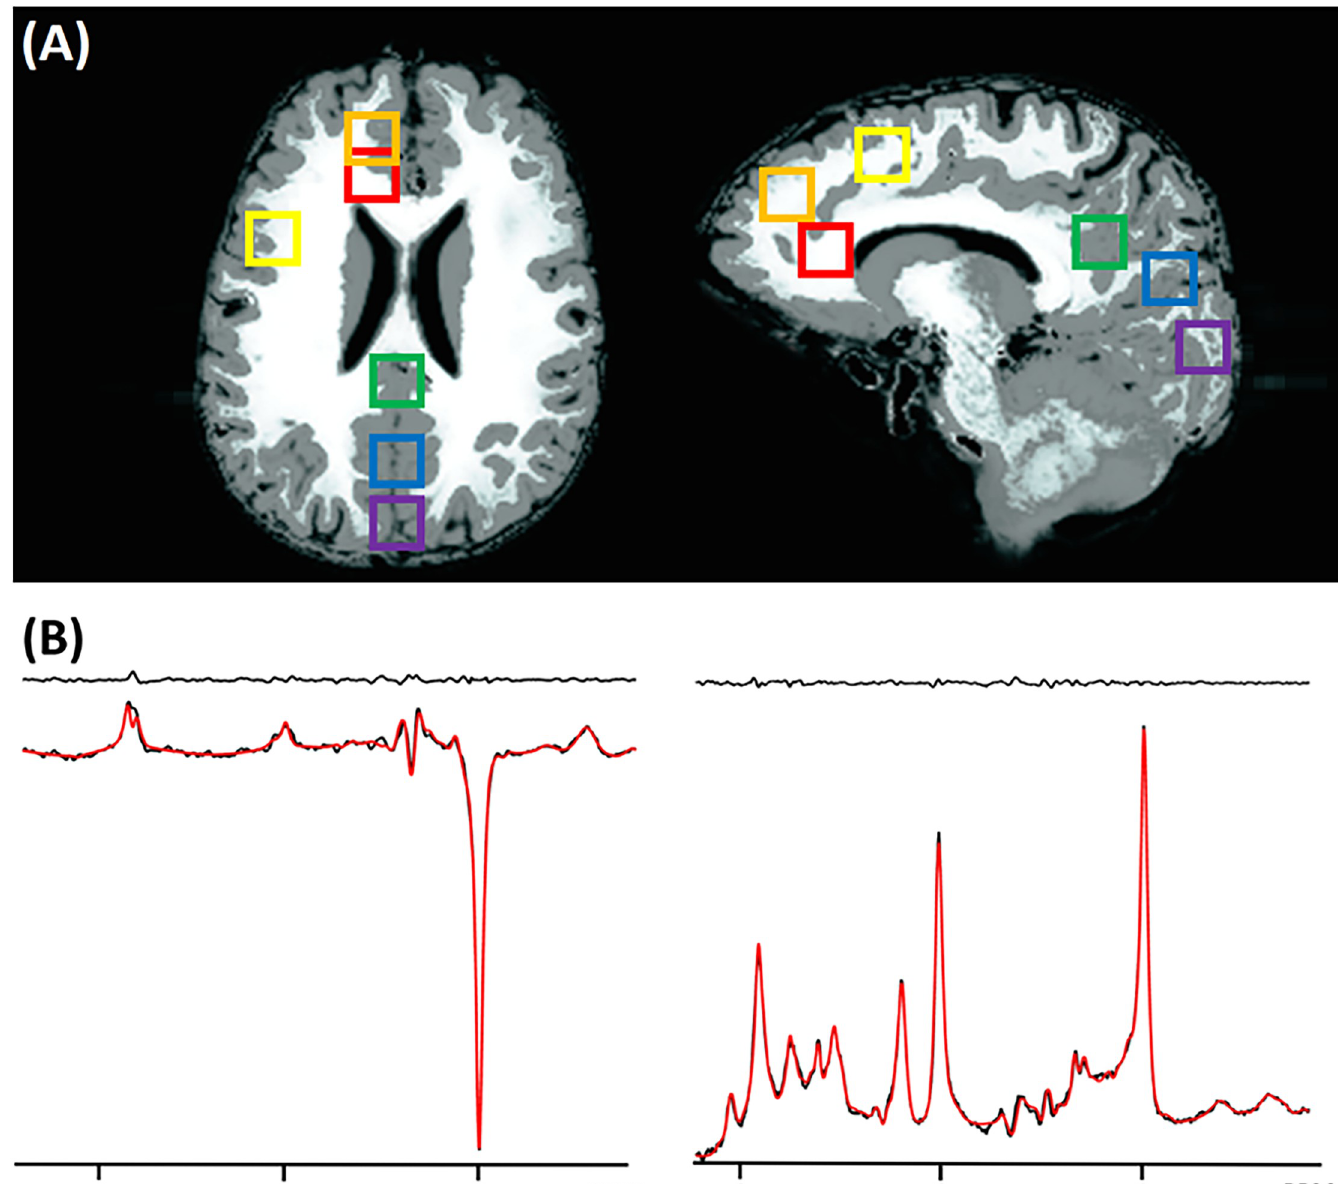
Fig 2. Spectroscopy voxel positions and exemplary results. (A) Six spectroscopy voxel positions: anterior cingulate cortex (AC: red), dorsolateral prefrontal cortex (DLPFC: orange), motor cortex (MC: yellow), occipital cortex (OC: purple), posterior cingulate cortex (PC: green), and precuneus (PRC: blue) on the GM (gray) and WM (white) map. (B) Example results of the LCModel analysis for the MEGA-sLASER (left) and the sLASER (right) that were acquired with the interleaved acquisition from a single voxel (PRC). The fitted line is plotted in red and residual signal (the difference between in-vivo and fitting lines) is plotted at the top.